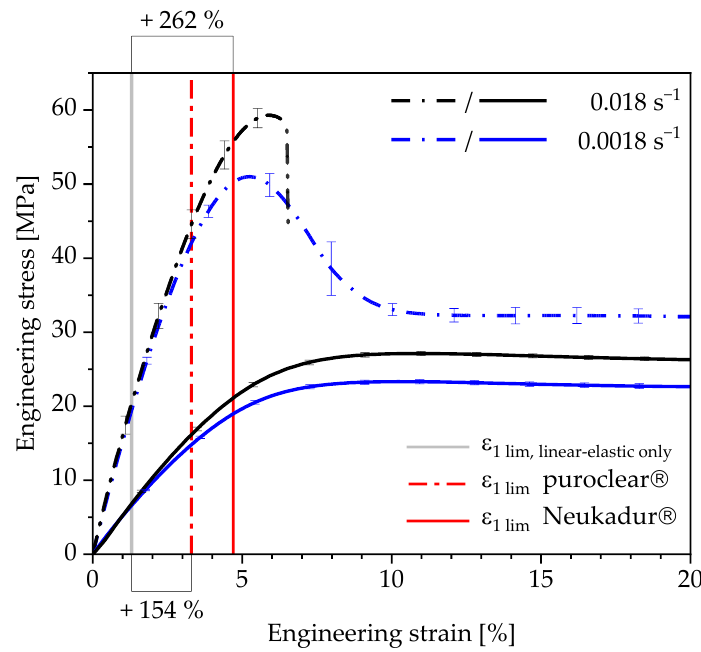
Figure 16. Determined strain limits for the polyurethane systems Neukadur ® and puroclear ® de- picted on the related stress–strain curves.